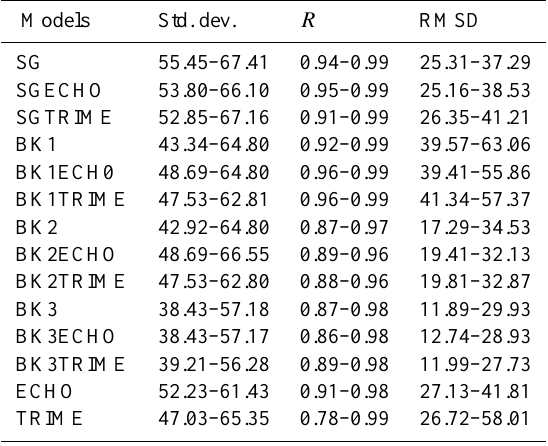
Table 5. Statistics of the model validation against WSC